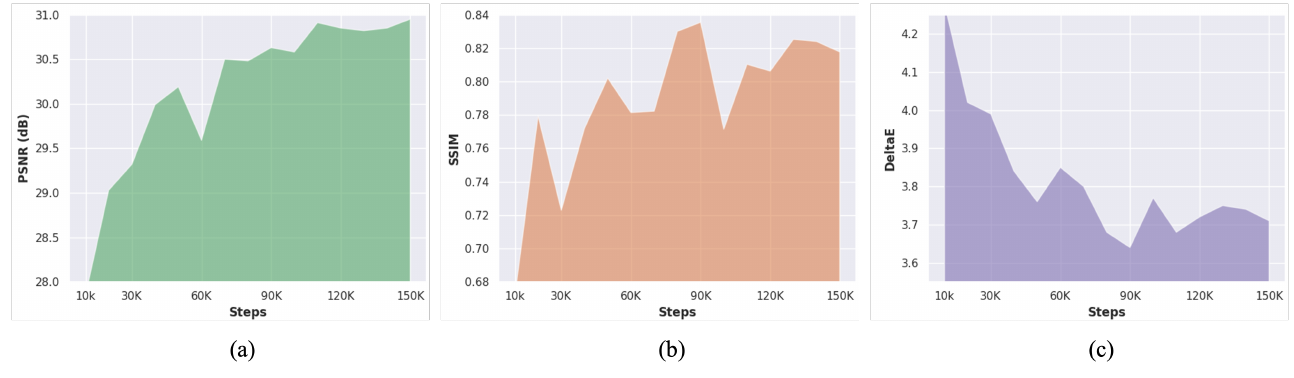
Figure 9. Learning medical image deblurring over training steps. ( a ) Steps vs. PSNR. ( b ) Steps vs. SSIM. ( c ) Steps vs.